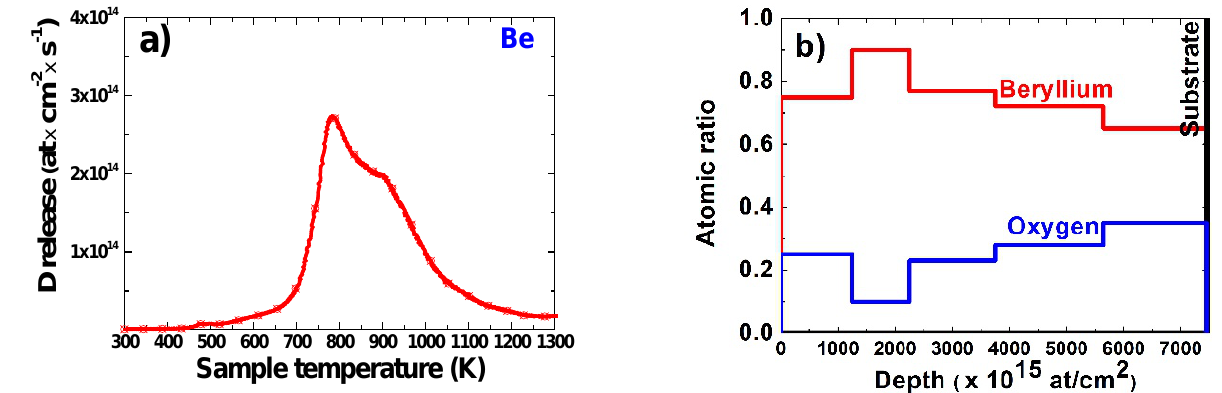
Figure 9. ( a ) Thermal desorption of D from Be layer; ( b ) Elemental depth profile resulted from SIMRA simulation of Be layer experimental RBS spectra.